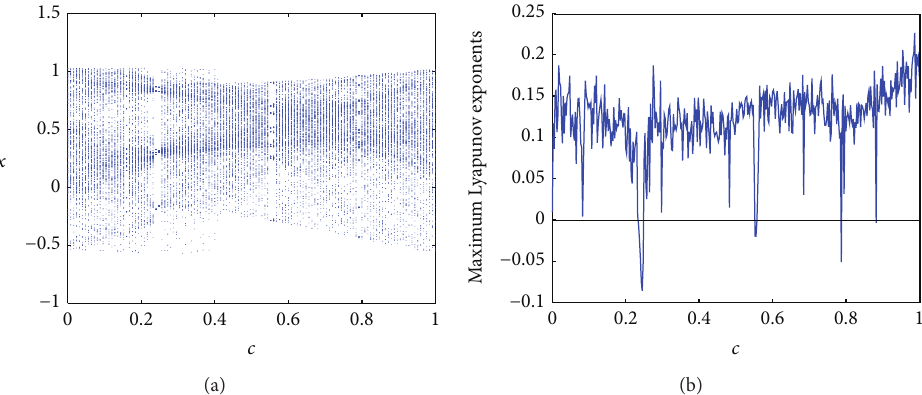
Figure 8: (a) Bifurcation diagram of map (2) in (𝑐, 𝑥) plane for 𝑎 = 0.2 , 𝑏 = 1 , 𝑑 = −1.5 , and 𝑒 = 0.23 . (b) Maximum Lyapunov exponents corresponding to